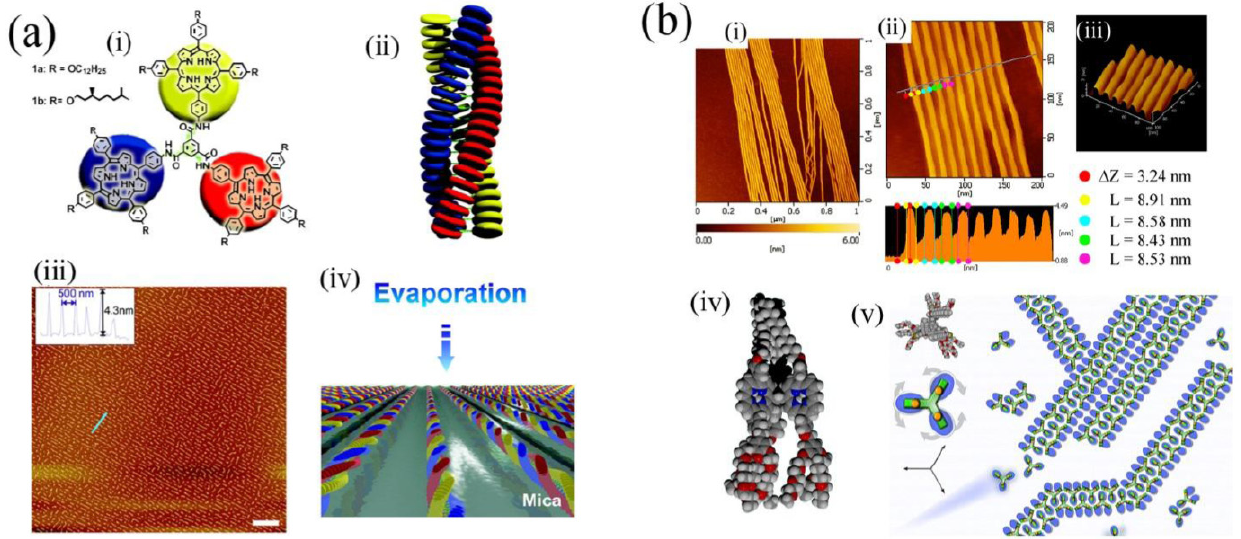
Figure 6. Self-assembling porphyrin trimers. ( a ) (i) 1,3,5-Triamide-centered triporphyrin and cartoon representation of its structure; (ii) Model of its structure in stacked self-assemblies; (iii) Regular nanowire structure obtained upon deposition of a solution of the porphyrin on a mica surface due to dewetting process; (iv) Model representing the mechanism of formation of the pattern from chloroform solution. Adapted from ref. [56]. Copyright (2008) American Chemical Society; ( b ) AFM imaging of amphiphilic benzene-1,3,5-triporphyrin nanowires formed on a mica substrate. (i) Overview; (ii) Dimension profiling (height, Δ Z ~3.24 nm, width, L ~8.5 nm); (iii) Topography of a parallel array of nanowires; (iv) Space-filling model of the structure of the triporphyrin molecule [C (gray), N (blue), O (red), H (white); (v) Model of nanowire structure. Top left: plan view of molecular conformation. Molecule is represented as a trefoil with rotatable arms which align in double rows. Adapted from ref. [57]. Copyright (2011) Royal Society of